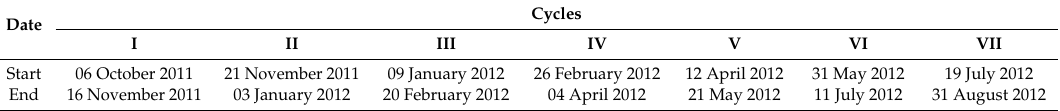
Table 1. Start and end dates for each